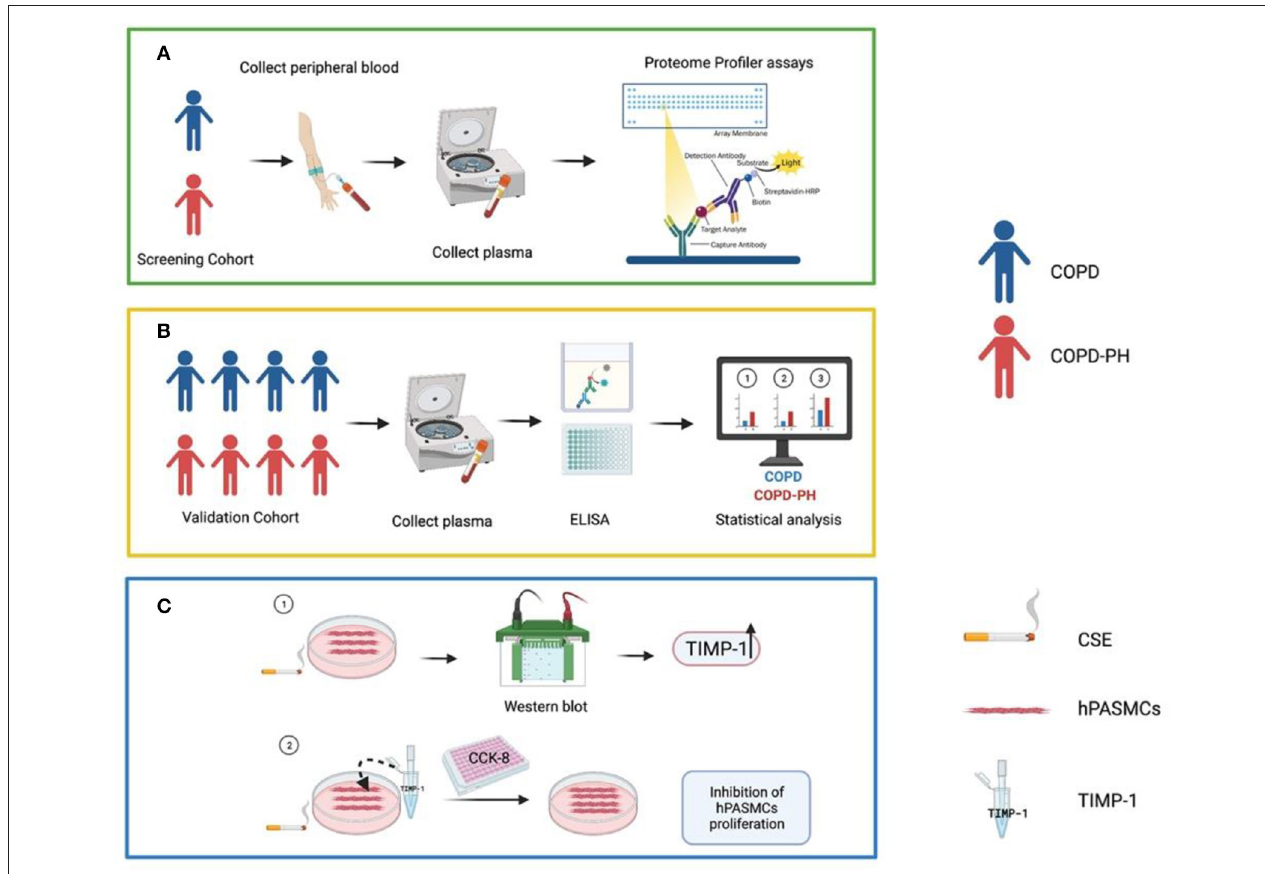
FIGURE 5 | Summary figure of the schematic workflow of the current study. (A) Initial screening of angiogenic factors and cytokines. (B) ELISA verification in validation cohort and related statistical analysis. (C) Involvement of TIMP-1 in the hPASMCs mechanism. COPD, Chronic obstructive pulmonary disease; COPD-PH, Chronic obstructive pulmonary disease associated pulmonary hypertension; CSE, Cigarette smoke exposure; ELISA, Enzyme-Linked Immunosorbent Assay; hPASMCs, Human Pulmonary Artery Smooth Muscle Cells; TIMP-1, Tissue Inhibitor of Metalloproteinases-1. This figure was created using